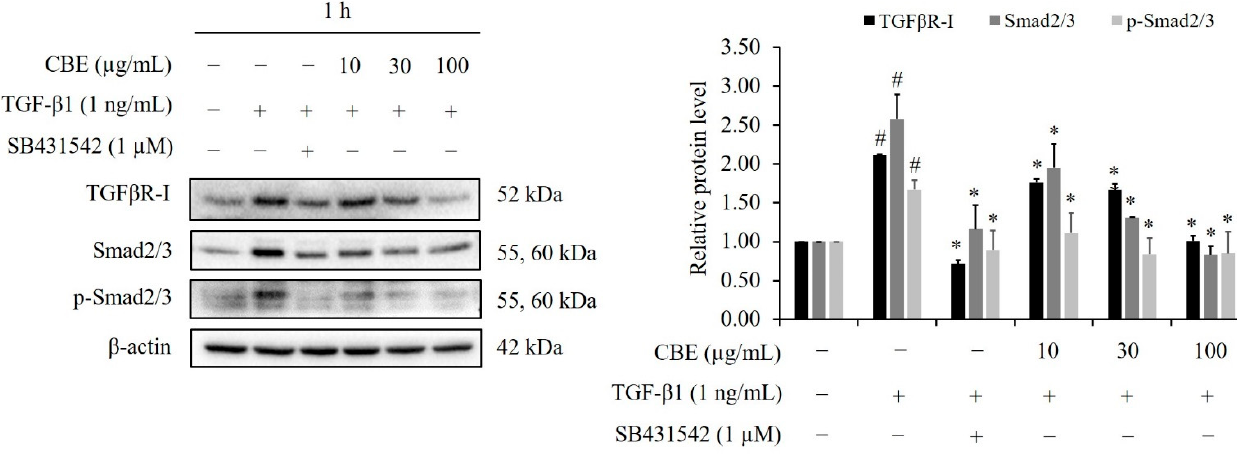
Figure 6. CBE reduces TGF- β 1-induced Smad2/3 phosphorylation. LoVo cells were pre-treated with CBE and SB431542, and were then stimulated with TGF- β 1 for an additional 1 h. TGF β R-I, Smad2/3, and p-Smad2/3 was determined by Western blotting. Results are presented as mean values ± SD ( n = 3). # p < 0.05 versus the control group. * p < 0.05 versus the TGF- β 1 treated group. CBE, Cinnamomum bejolghota extract; SD, standard deviation.